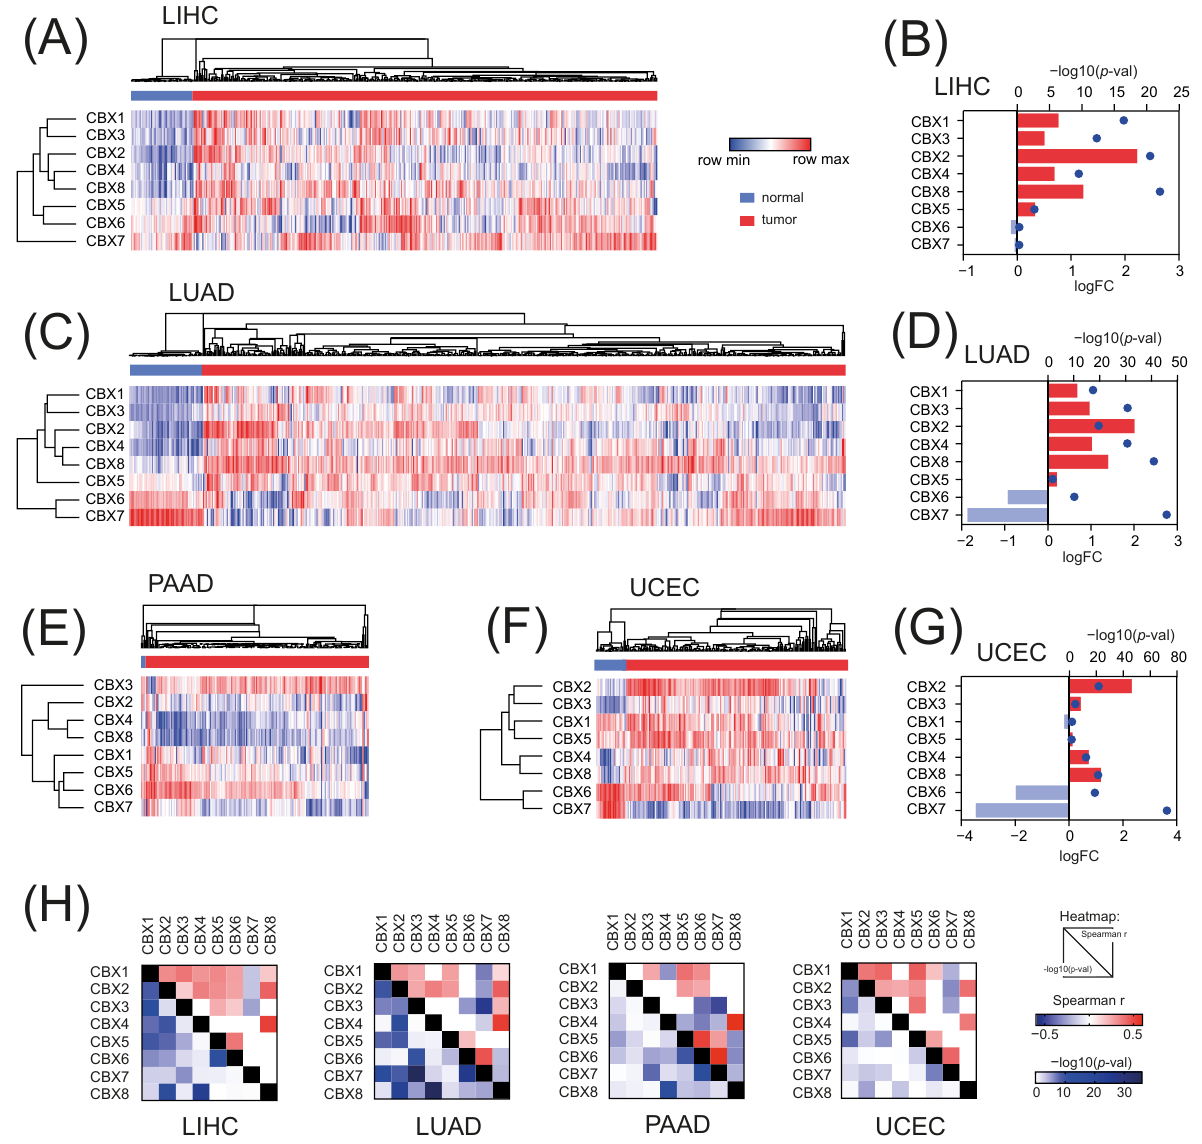
Figure 1. The expression of CBX family members in selected TCGA tumors. The level of CBX family members and differential CBX expression between tumor and normal adjacent tissues in ( A , B ) liver, ( C , D ) lung, ( E ) pancreatic and ( F , G ) uterine tumors. In the heatmaps, blue and red denotes low and high expression, respectively. Sample groups are color-coded accordingly: blue— normal tissue; red—tumor tissue. Bar plots depict the fold change (log2) of CBX expression in tumor vs. normal tissues. The statistical significance ( − log10( p -value)) is marked with blue dots. ( H ) The correlation of CBXs expression in selected TCGA tumors. The upper part of the heatmaps presents the Spearman correlation coefficient, while the lower part shows the statistical significance of the correlation ( − log10( p